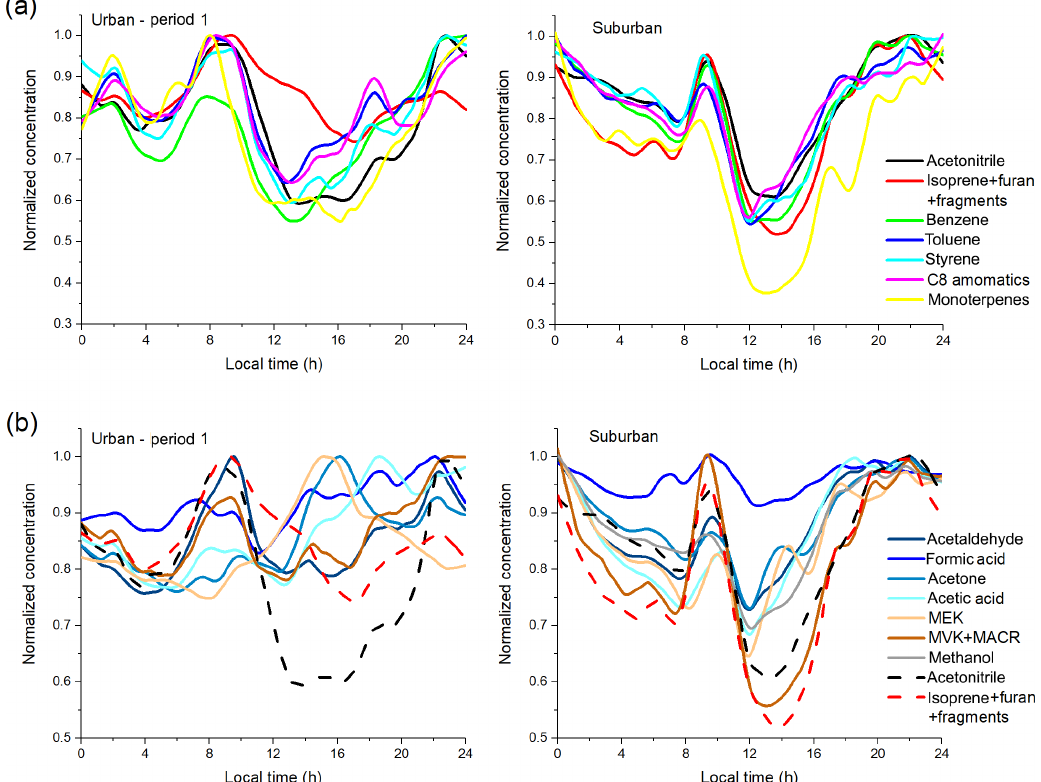
Figure 5. Diurnal variations of VOCs at urban and suburban sites: (a) hydrocarbons and acetonitrile; (b) OVOCs (with acetonitrile and isoprene for comparison). Note that methanol at the urban site is not shown because of the dramatic influence of solvent